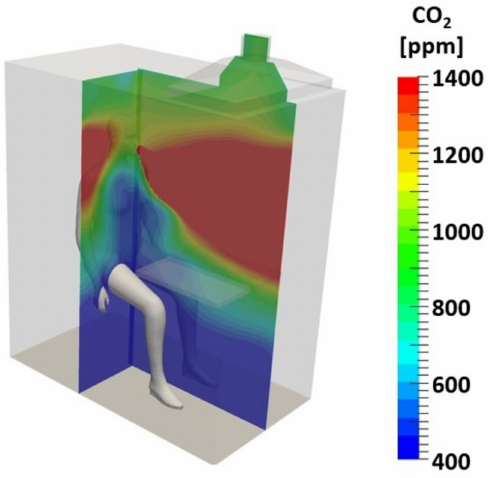
Figure 8. CFD simulation of the CO 2 concentration in the exposure